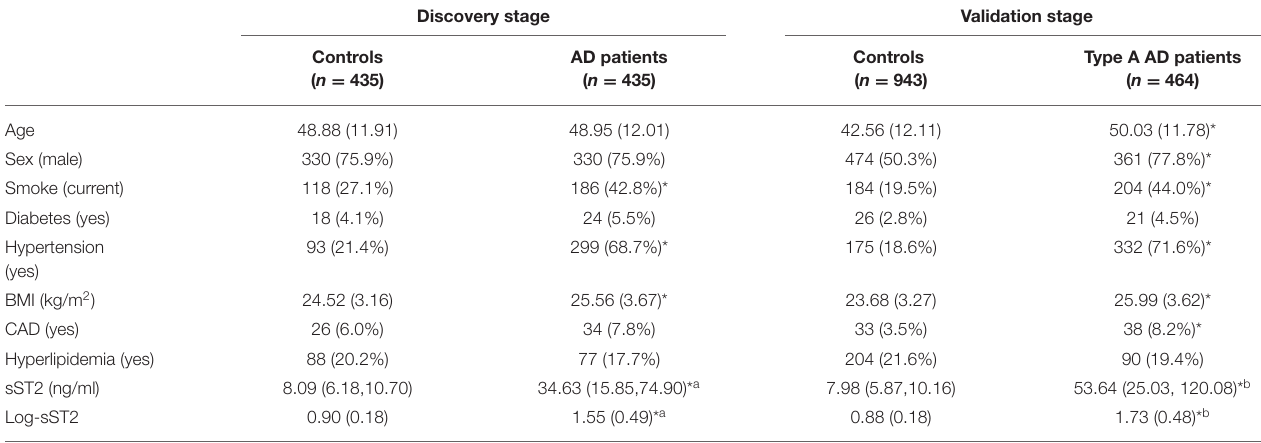
TABLE 1 | Summary of participant characteristics.